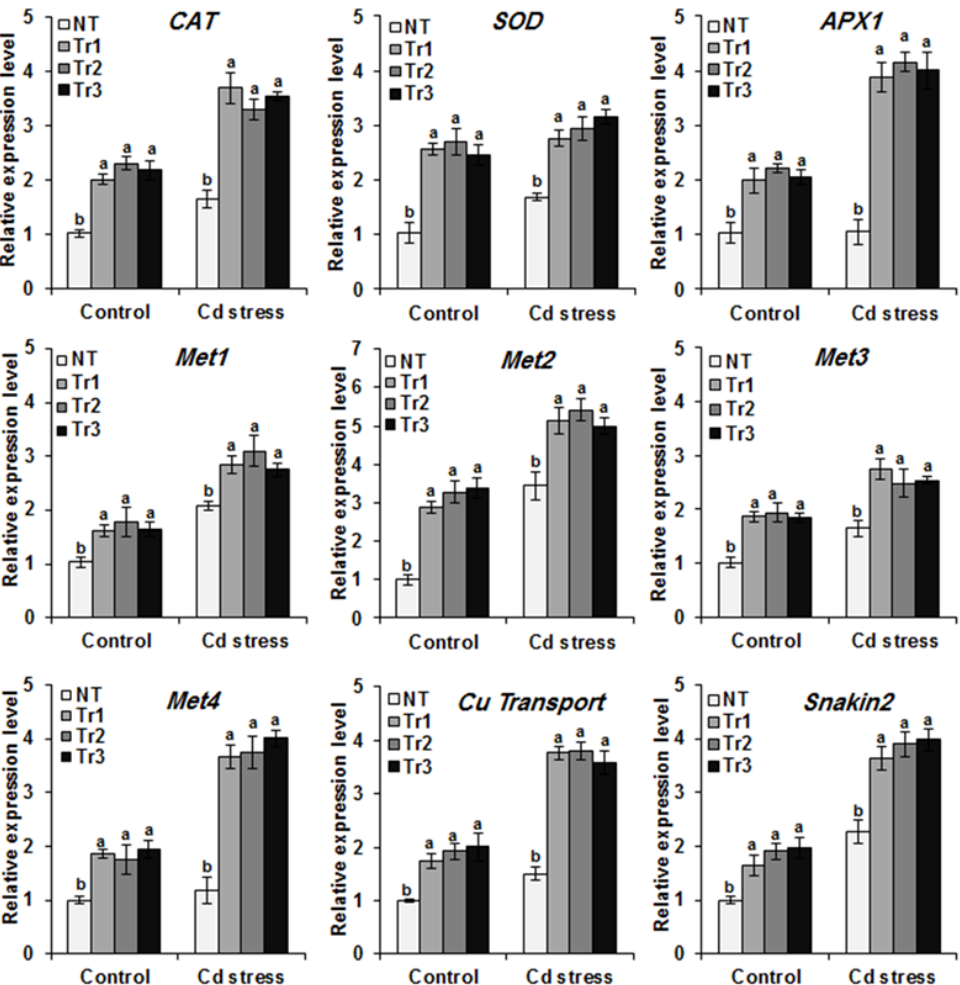
Figure 7. Expression of the pattern of Cd-tolerance/detoxification genes in NT and transgenic plants (Tr1, Tr2, and Tr3) under MS (control), Cd, or Cu stress conditions. The means denoted by the same letter did not differ significantly at p < 0.05.